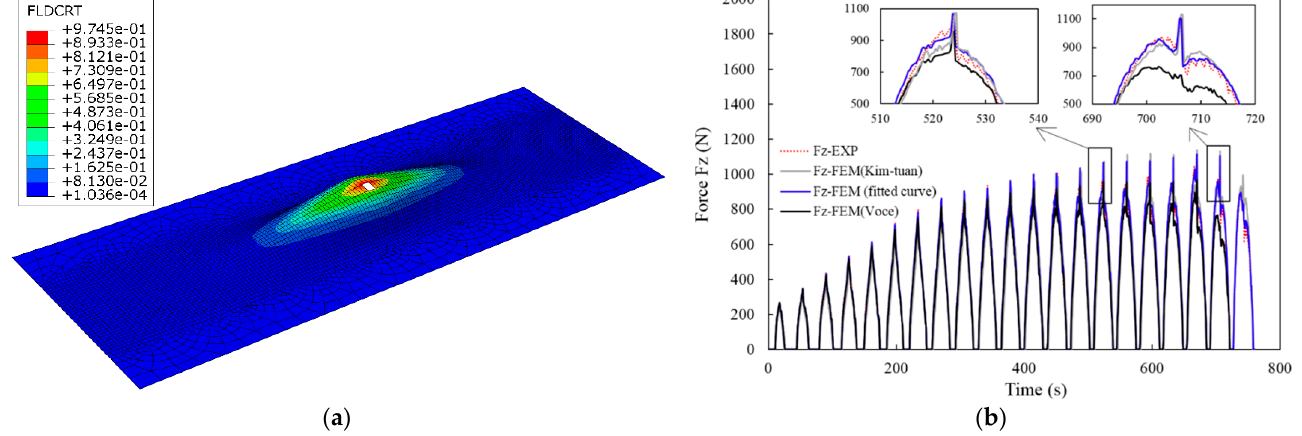
Figure 10. ( a ) Fracture prediction by FEM with the best-fitted trial stress–trial strain curve. ( b ) Comparison of the experimental force and force prediction by FEM with different hardening equations. Table 3. Measured maximum forming force at 15th and 20th